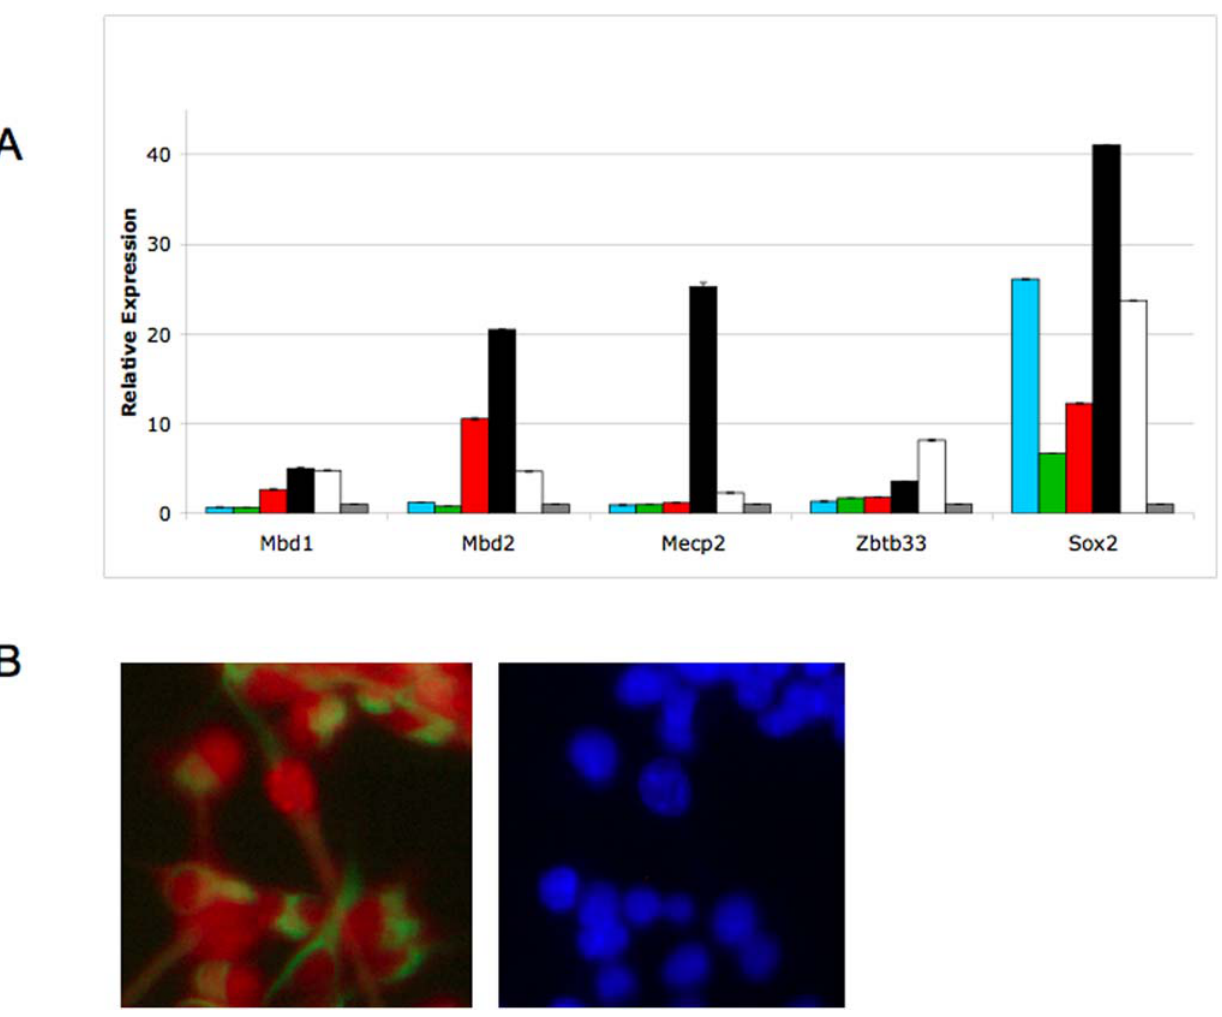
Figure 2. Methyl-CpG binding proteins in NS cells. Expression of Mbd1 , Mbd2 , Mecp2 , Zbtb33 and Sox2 detected by RT-PCR in ES cells (blue boxes), FACS-purified, Sox1-expressing ES-derived neural progenitors (green boxes), NS cells (red boxes), NS cell -derived neuronal cultures (black boxes), NS cell -derived astrocyte cultures (white boxes), and whole brain (grey boxes). Error bars indicate SEM. For each cell sample, expression was normalized to Gapdh expression, and is shown relative to that seen in adult mouse brain. B. Detection of Mecp2 protein in NS cells. Mecp2 can be detected by antibody staining (red) in NS cell cultures, also expressing the NS cell marker RC2 (green). The Dapi-stained image is shown at right.